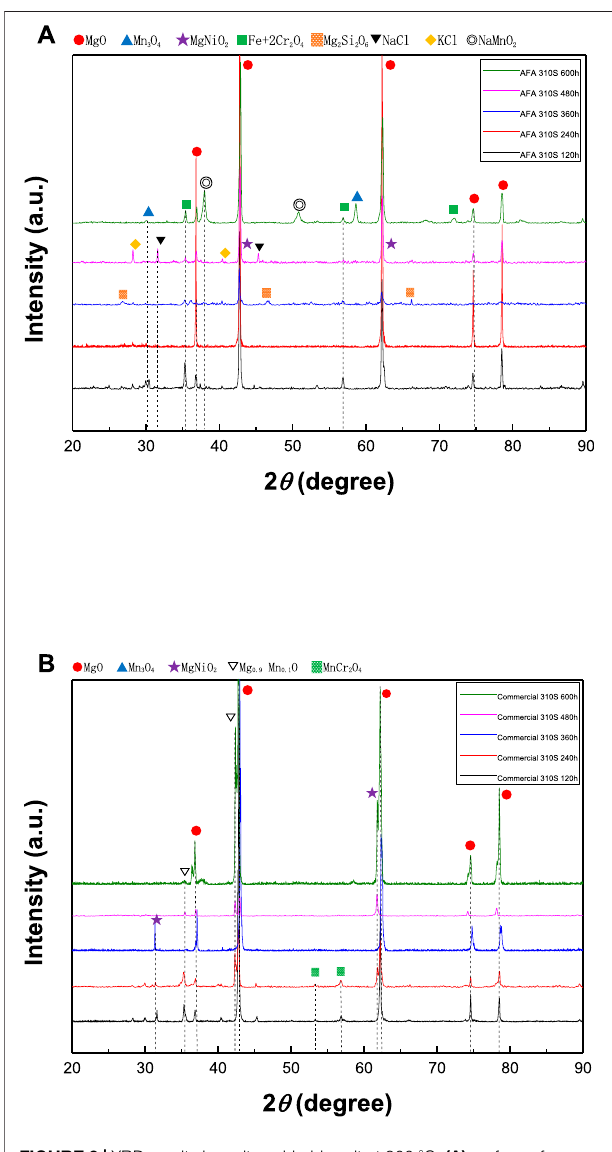
FIGURE 3 | XRD results in molten chloride salt at 800 ° C: (A) surface of AFA 310S in 120, 240, 360, 480, and 600 h, (B) surface of commercial 310S in 120, 240, 360, 480, and 600